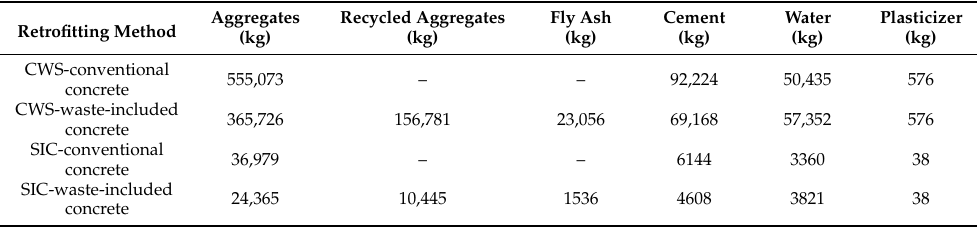
Table 2. Materials required for retrofitting with CWS and SIC-based conventional and waste- included